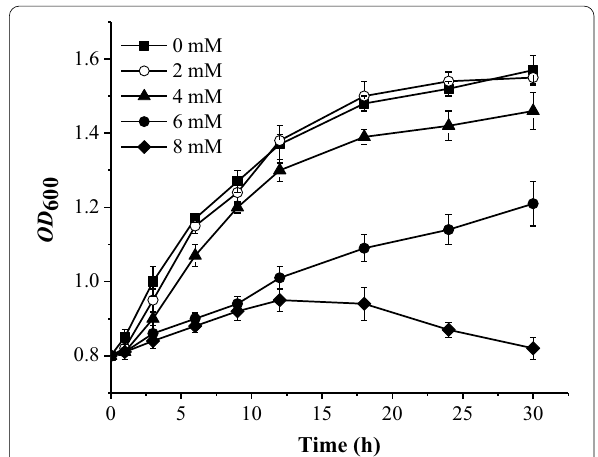
Fig. 4 Growth curves of BL- fpd with different concentrations of 4-FP. The data are the mean SD for three independent experiments ±